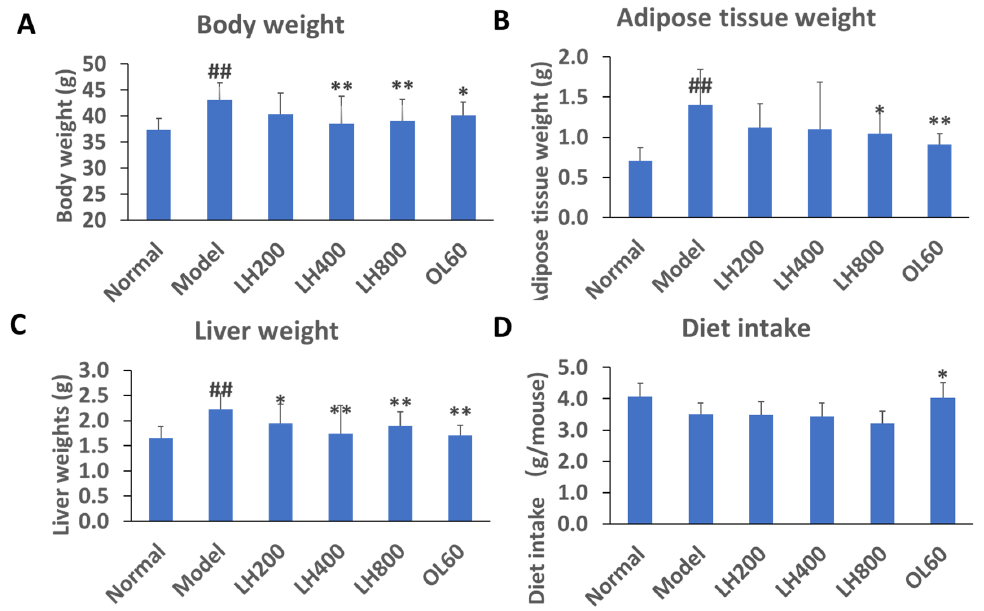
Figure 1. Effects of mogrosides (luo han guo, LH) on ( A ) body, ( B ) abdominal adipose, and ( C ) liver tissue weight and ( D ) diet intake of mice. Data are presented mean ± SD, ## P < 0.01 vs normal group; * P < 0.05 and ** P < 0.01 vs. high-fat control group, n = 10. Normal, normal group; model, high-fat control group. LH200, LH400, and LH800: groups orally treated with LH at dosages of 200, 400, and 800 mg/kg/day, respectively; OL60: group orally treated with Orlistat (OL) at 60 mg/kg/day.